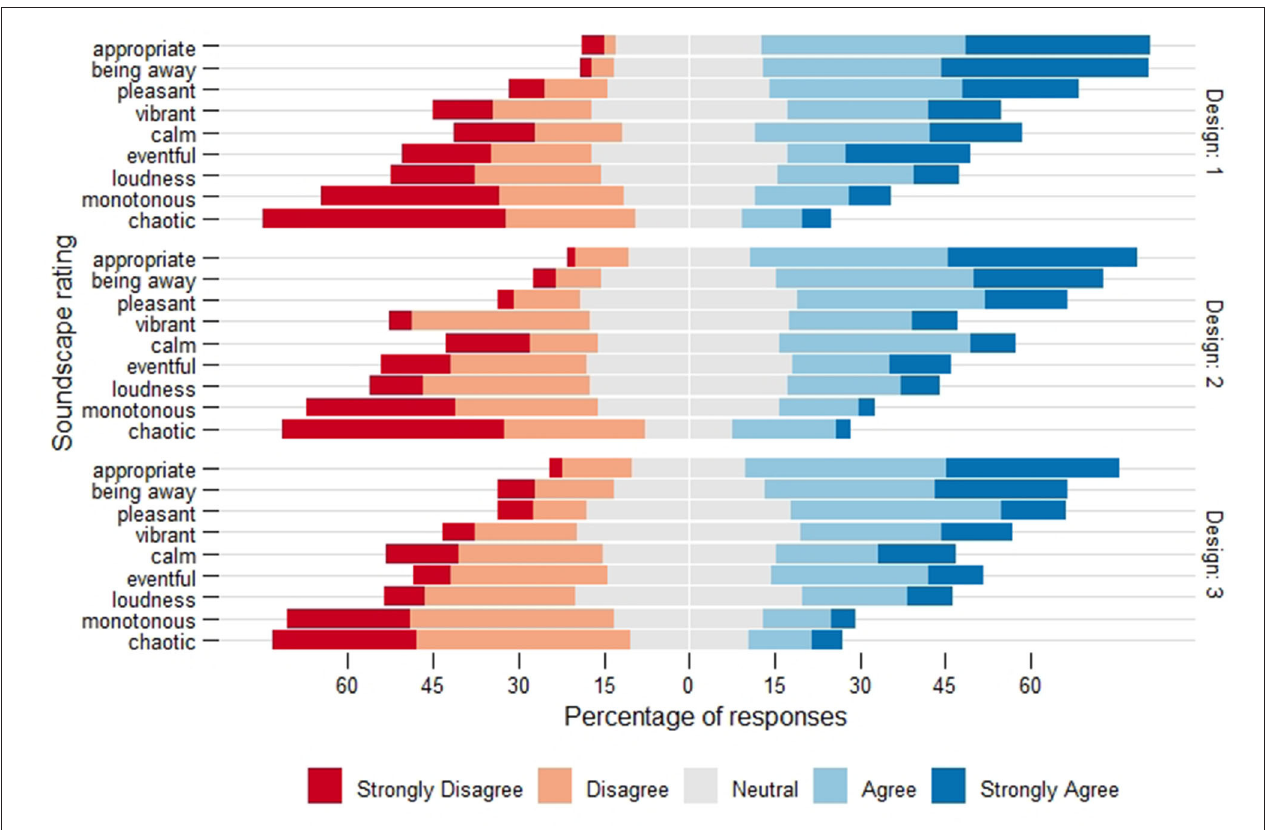
FIGURE 3 | Distribution of the Likert-scale soundscape ratings for each design. Respondents generally found the sound environment was appropriate for activity, provided an opportunity for a break and was pleasant. As well, they disagreed that the sound environment was monotonous and chaotic. No significant differences were found across designs.